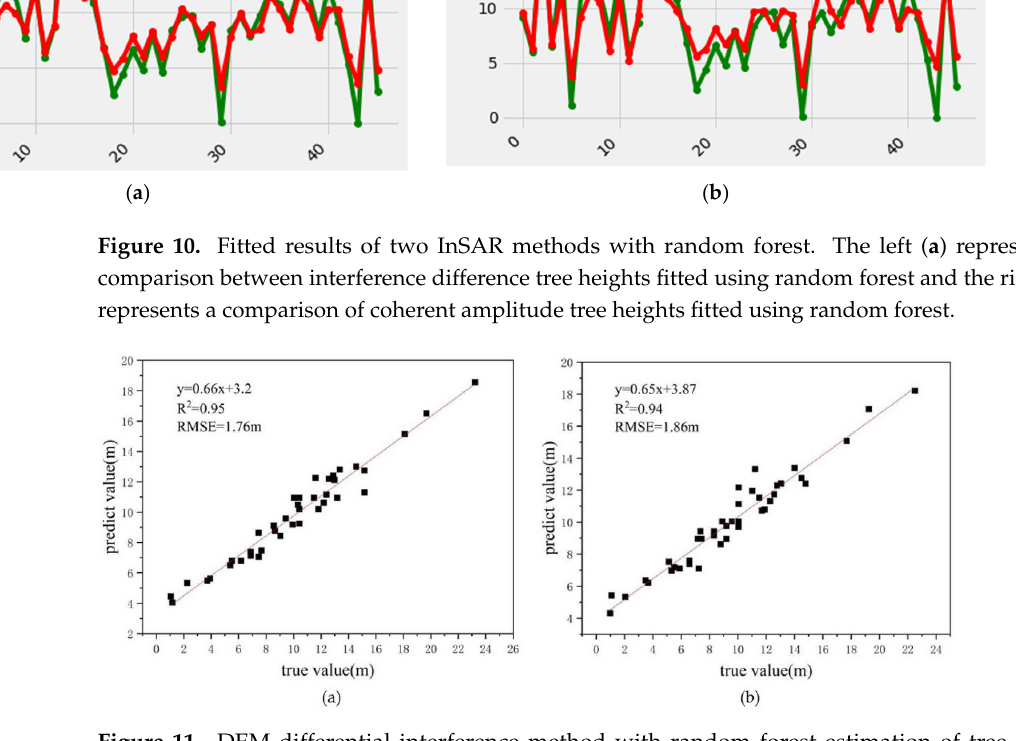
Figure 12. DEM differential interference method with random forest estimation of height residuals: ( a ) predicted residuals of true tree height; ( b ) counts of predicted residuals; ( c ) predictive residuals of predicted value; ( d ) percentile of predictive residuals. As shown in Figure11a, the regression model established between the phase center height measured by the DEM differential interference method and actual tree height using random forest had a root mean square error of 1.76 m. The linear fit between the predicted and true values was 0.95, which indicated that the forest tree height could be estimated relatively well using the random forest algorithm. It also indicated that the tree height values measured using differential interferometry could be interconverted with the actual tree height after correction for topographic factors. The use of the random forest algorithm can solve the problem associated with the scattered phase center height and canopy height of C-band SAR data having different resolutions and complex terrain factors.